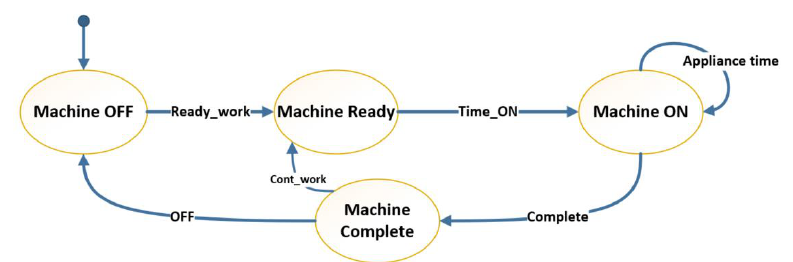
Figure 7. Appliances finite state machine.